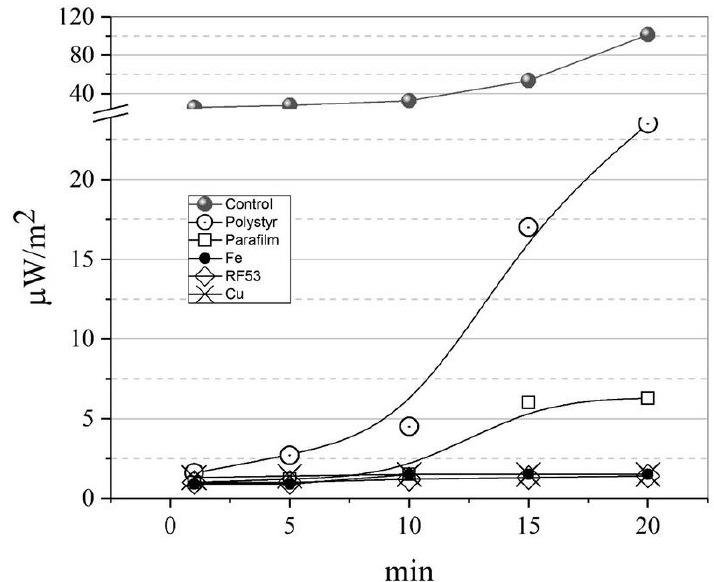
Figure 6. Shielding of the thermal radio emission of the INF-α preparation with screens made of polystyrene (labelled “Polystyr” on the graph; thickness—1 mm), parafilm (“Parafilm”; 1 mm), steel (“Fe”; 5 mm), fabric with copper–nickel particles “RF53” (1 layer), copper grid (“Cu”; 0.2 mm; cell pitch—1 mm). Table 5. Average characteristics of the intensity of the intrinsic radio emission of preparations in the frequency range of 68 GHz–111 GHz. Lactose Background AINF- γ Placebo (Powder) (Empty